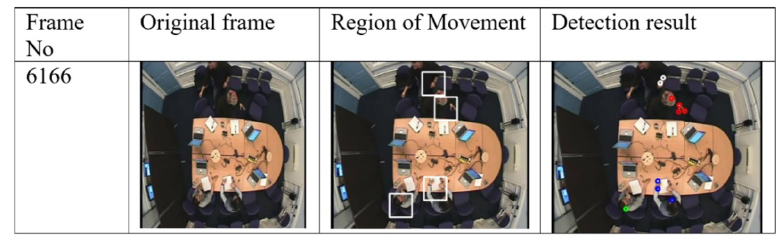
Figure 7. Sample image to show detection result when meeting participants are near each